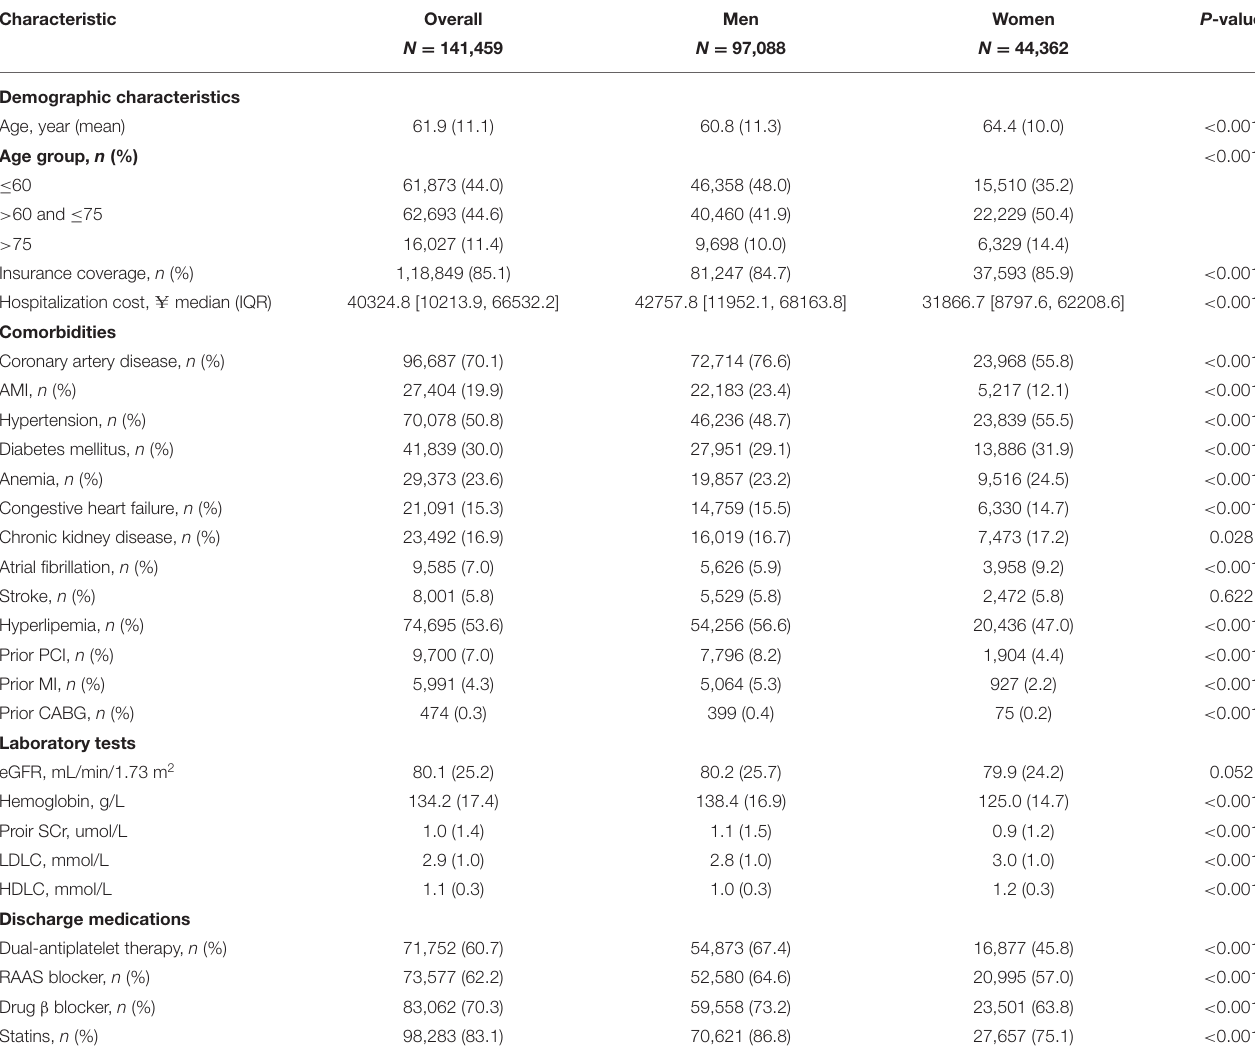
TABLE 1 | Demographic and clinical characteristics of patients undergoing CAG and/or PCI from 2007 to 2020. Characteristic Overall